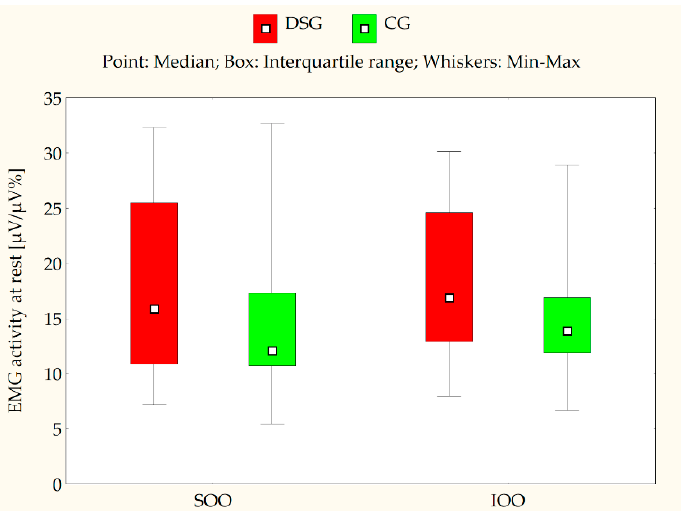
Figure 5. EMG activity of the superior orbicularis oris (SOO) and inferior orbicularis oris (IOO) muscles (µV/µV%) at rest in the Down syndrome group (DSG) and the control group (CG); p > 0.05.